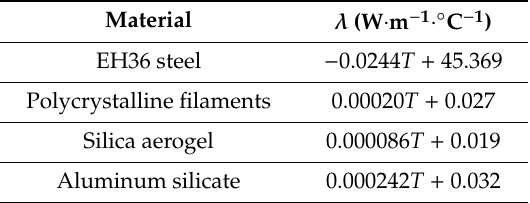
Table 3. Physical properties of materials used in panel